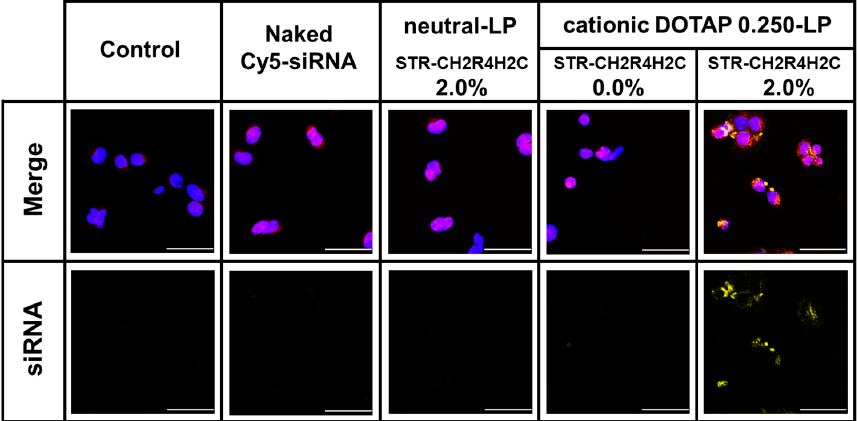
( b ) Figure 2. Cellular uptake of STR-CH2R4H2C-LP-siRNA lipoplexes and unmodified-LP-siRNA lip- oplexes. Mean fluorescence intensities (MFI) per cell of ( a ) ATTO-labeled liposomes and ( b ) Cy5- siRNA in rat RPE cells. Neutral-LP-siRNA lipoplexes, DOTAP0.250-LP-siRNA lipoplexes, 2.0 mol% STR-CH2R4H2C-neutral-LP-siRNA lipoplexes, or 2.0 mol% STR-CH2R4H2C-DOTAP0.250-LP- siRNA lipoplexes were transfected into RPE cells (2.0 × 10 5 cells) in serum-free DMEM for 4 h (ATTO-DOPE, 0.2 µM; Cy5-siRNA, 0.158 µM). MFI per cell was measured by flow cytometry for 10,000 events. Each bar represents the mean ± SD ( n = 3). N.S. p > 0.05, ** p < 0.01.